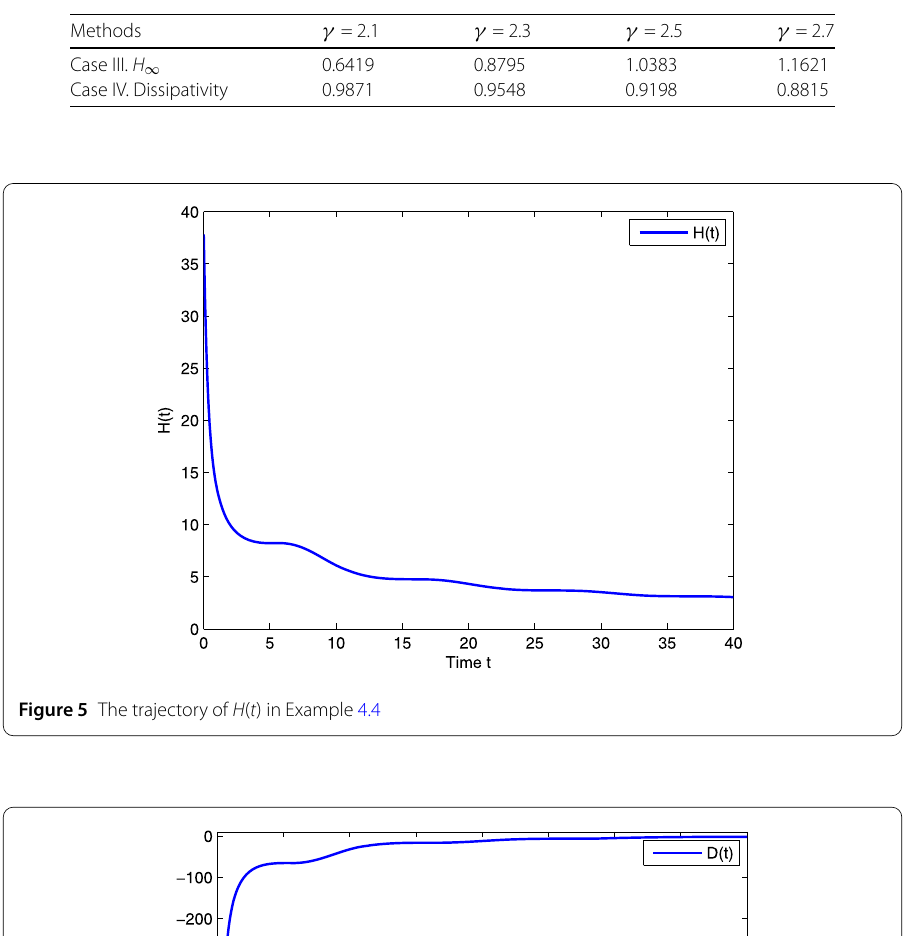
Table 5 The maximum allowable values of δ 2 for Case III and Case IV in Example 4.4 with δ 1 = 0.5, and various γ